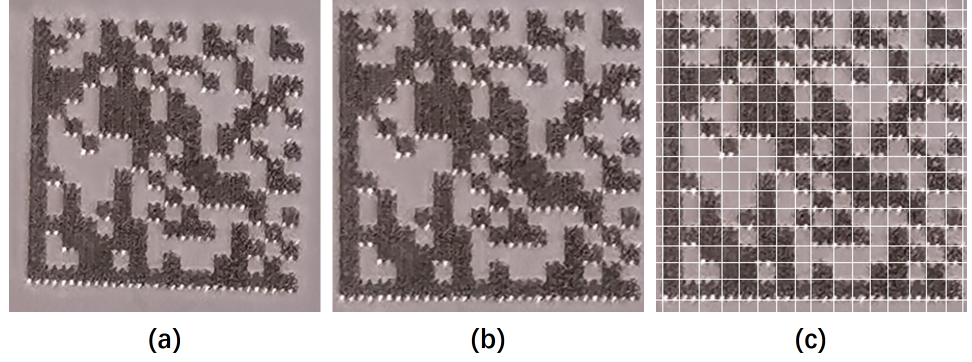
Figure 3. Image pre-processing procedure: ( a ) an original barcode image with geometric deforma- tions; ( b ) barcode image after deformation correction; ( c ) the barcode image with an aligned grid.